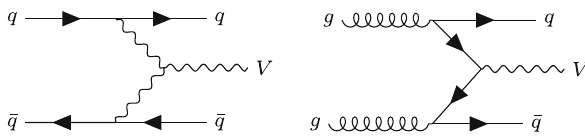
Fig. 4 Representative diagrams for dominant background processes through (left) VBF type weak production and (right) QCD production of massive vector-bosons V , such as W or Z which decay invisibly by producing undetected lepton or neutrinos